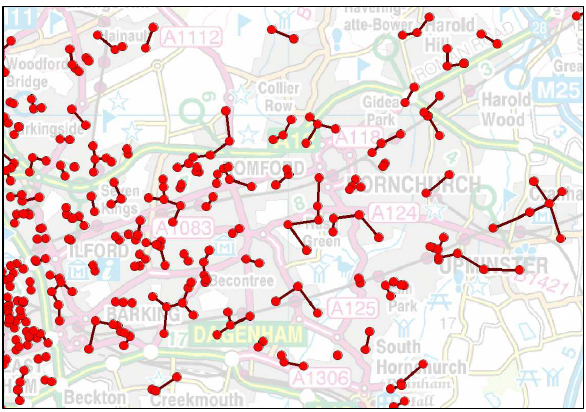
Figure 7. ArcInfo Near Function Used to Match